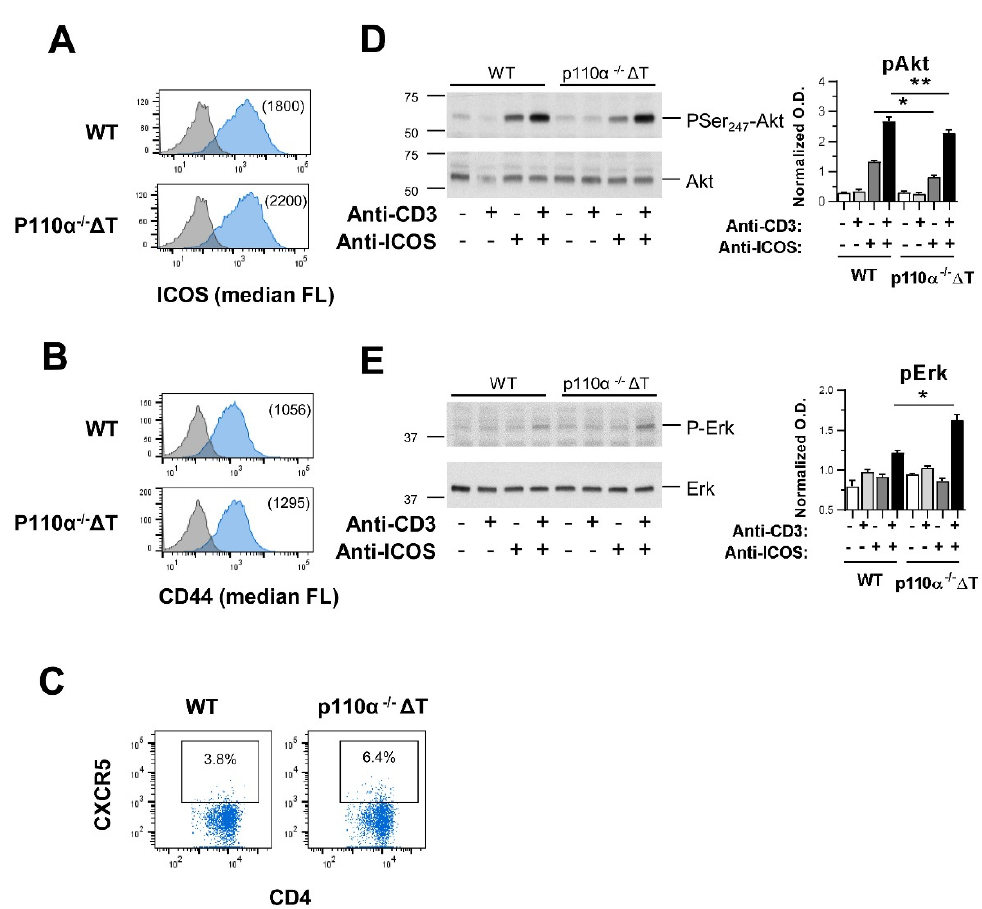
Figure 7. In vitro analysis of T-cell blasts of p110 α − / − ∆ T: expression of surface markers and intracellular signaling. Differences in the expression of ( A ) ICOS, ( B ) CD44, or ( C ) CXCR5 in CD4 + T-cell blasts from WT and p110 α − / − ∆ T mice. Numbers in parenthesis in ( A , B ) are the median of fluorescence intensity for ICOS and CD44, respectively. The percentage of CXCR5 + cells in ( C ) is indicated in each figure. ( D , E ) Early intracellular signaling measured as ( D ) phospho-Akt Ser473 and ( E ) phospho-Erk in CD4 + T-cell blasts activated for 20 min with latex beads coated with anti-CD3, anti-ICOS, anti-CD3 and anti-ICOS antibodies, or control antibodies, as indicated. Phospho-Akt Ser473 ( D ) or phospho-Erk ( E ) in the cell lysates was determined by immunoblot with specific antibodies. Protein load was determined with anti-Akt or anti-Erk antibodies to determine normalized O.D. values, as shown in accompanying graphs (right). Graphs show mean ± SEM of triplicate determinations. * p < 0.05; ** p < 0.01.